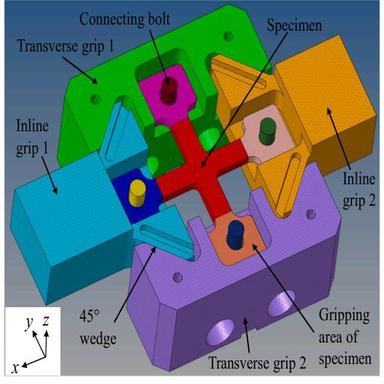
FE model of the assembly consists of the grips, connecting bolts and the specimen.